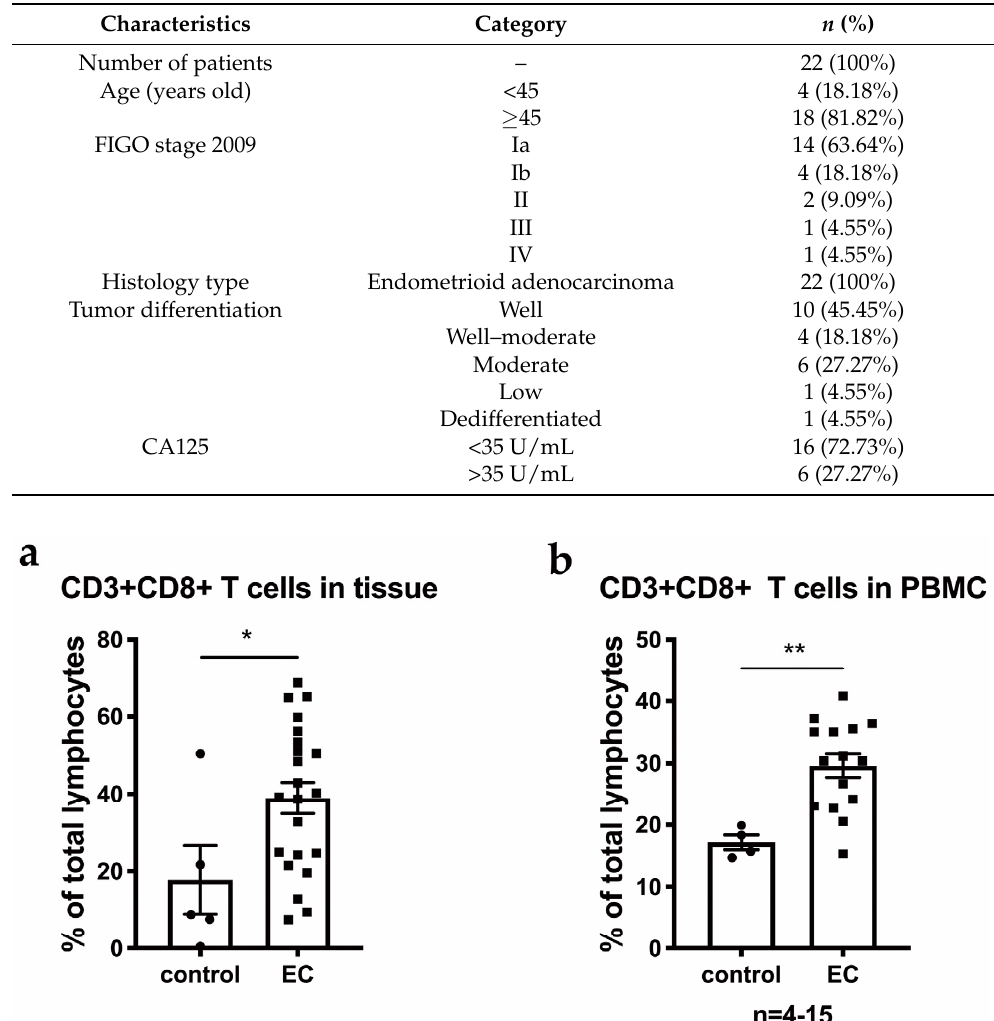
Table 1. Characteristics of the patients enrolled for flow cytometry.